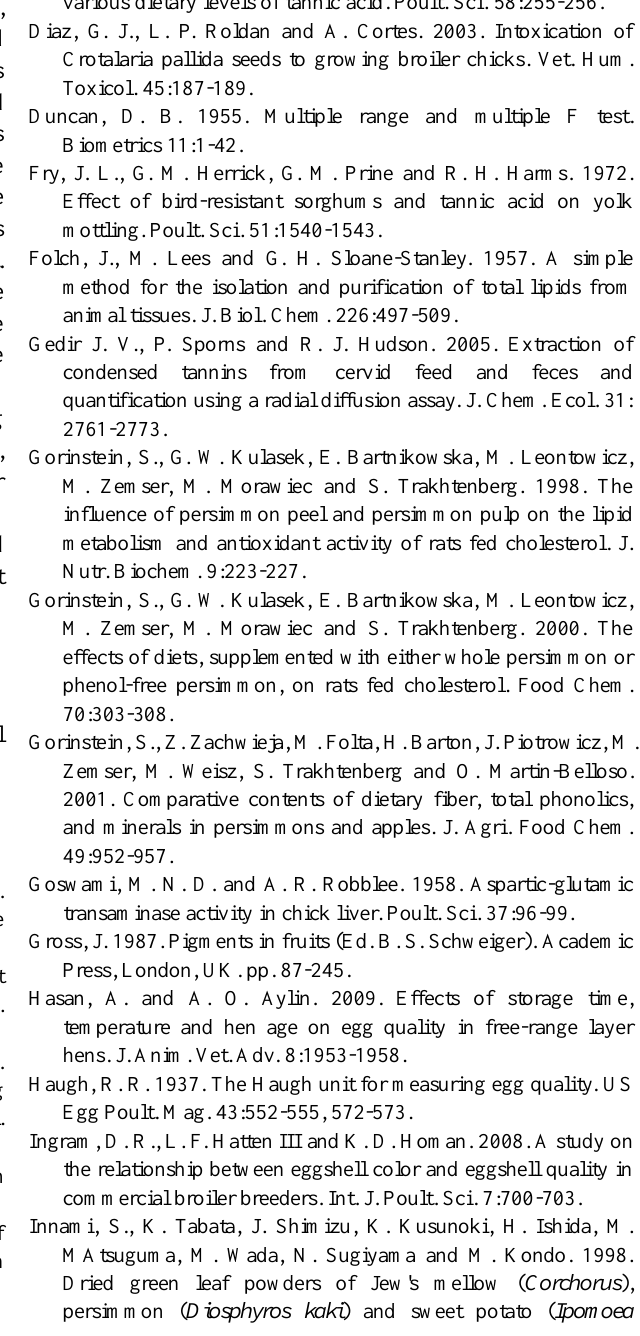
1 Values are presented mean  SE (mean  SE of 4 groups, each group was composed of 3 cages, 2 hens per cage). a-c Values with different superscript were significantly differ